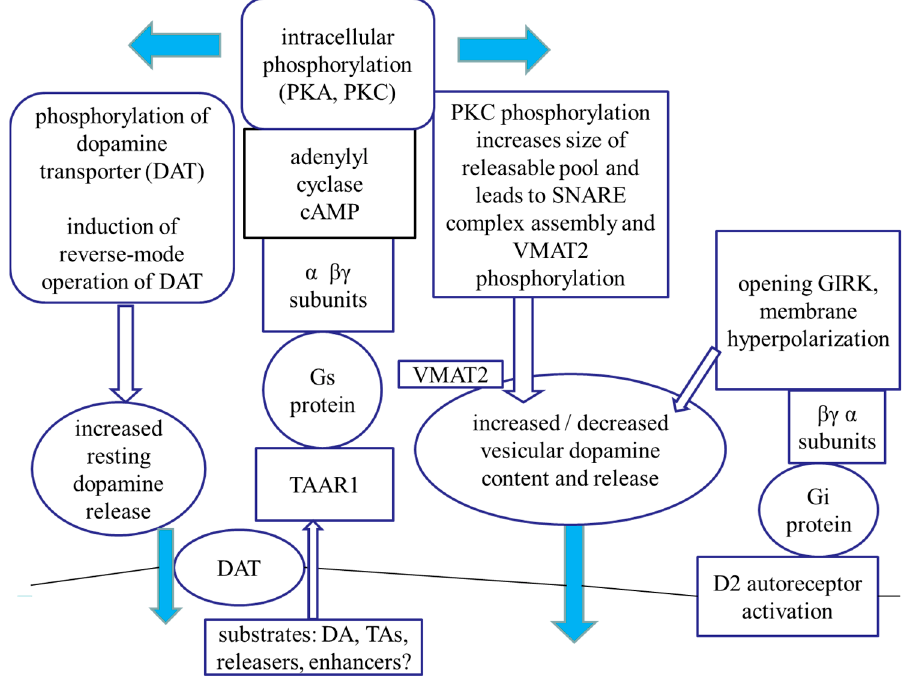
Figure 23. Hypothetical model of the trace amine-associated receptor 1 (TAAR1) signaling involved in the regulation of presynaptic dopaminergic neurotransmission. Activation of the Gs protein- coupled TAAR1 by classical or trace amines and exogenous releaser drugs (amphetamines) results in adenylyl cyclase activation followed by an increased intracellular cAMP production and, as a consequence, an increase in PKA/PKC-mediated intracellular phosphorylation. Activation of PKC phosphorylates plasma membrane dopamine transporter (DAT) as well as proteins involved in SNARE core complex assembly leading to non-vesicular and vesicular dopamine release, respectively. Moreover, PKC also phosphorylates vesicular monoamine transporter 2 (VMAT2) and the increased dopamine accumulation causes elevated vesicular dopamine content and release. Dopamine released into the synaptic cleft activates D2 autoreceptor-mediated presynaptic feedback inhibition, which then leads to the opening of GIRK and the resulted hyperpolarization of the cell membrane suspends further release of dopamine. Our working hypothesis is that TAAR1 possesses a central role in the regulation of DAT, dopamine-containing vesicle operation, readily releasable pool and SNARE core complex assembly and feedback inhibition of dopamine release also. We have speculated that the enhancer drugs (( − )BPAP) activate TAAR1 signaling and the reserpine-sensitive PKC pool and phosphorylation of the proteins in SNARE core complex and VMAT2 leads to increased vesicular dopamine release, i.e., enhancer